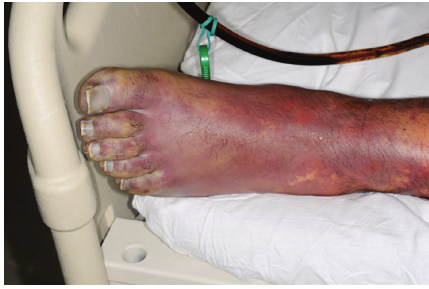
Figure 1: Ecchymotic nonblanching macular lesions on the hand.